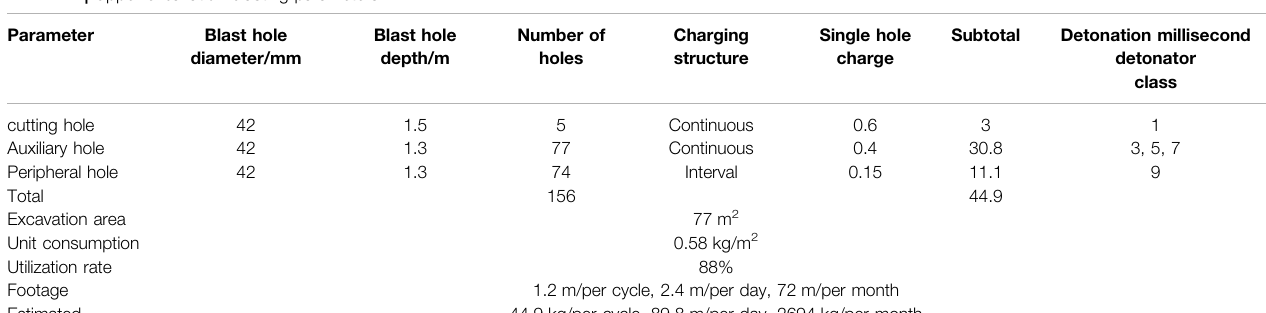
TABLE 1 | Upper excavation blasting